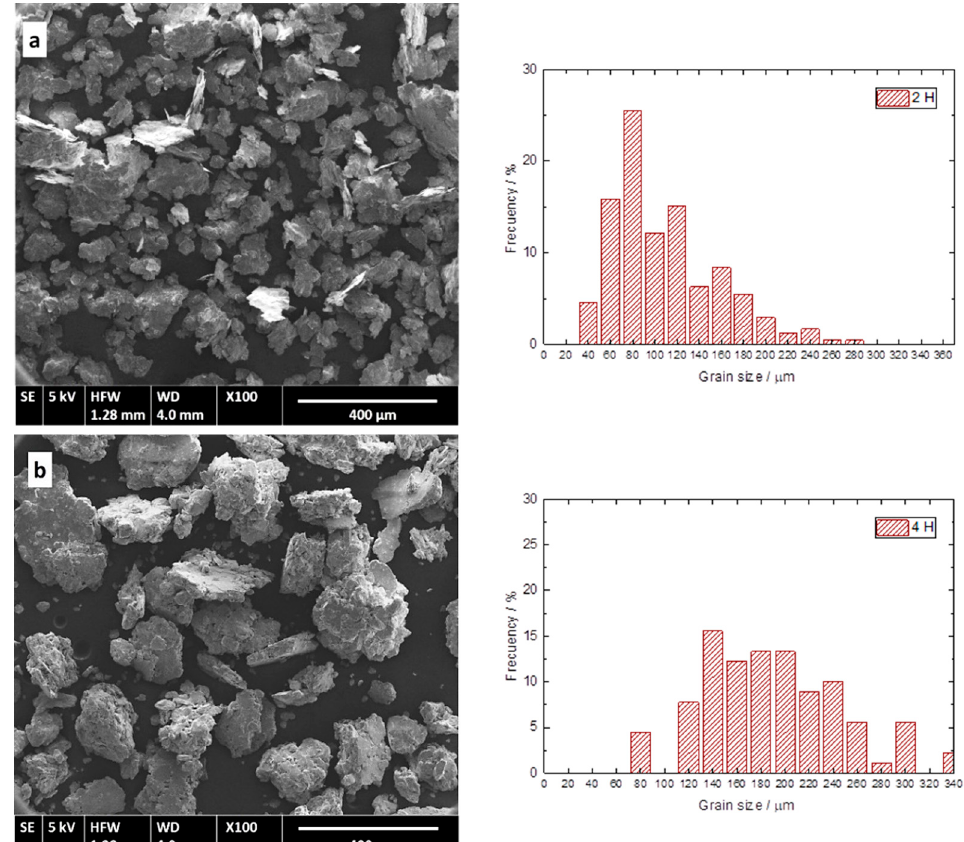
Figure 9. SEM micrographs of AA7075 powders after milling in the first stage of the H + LEBM route with the corresponding particle size distribution: ( a ) 2 h of milling; ( b ) 4 h of HEBM without addition of MWCNTs.